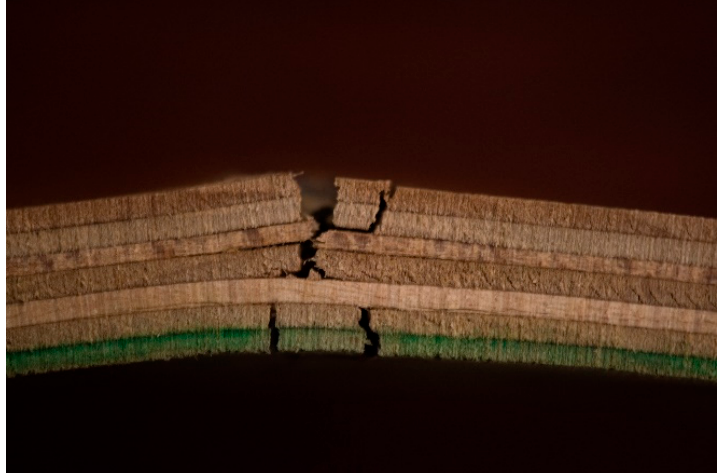
Figure 20. Cross Section View Showing Four Layer Split in Sample 1.